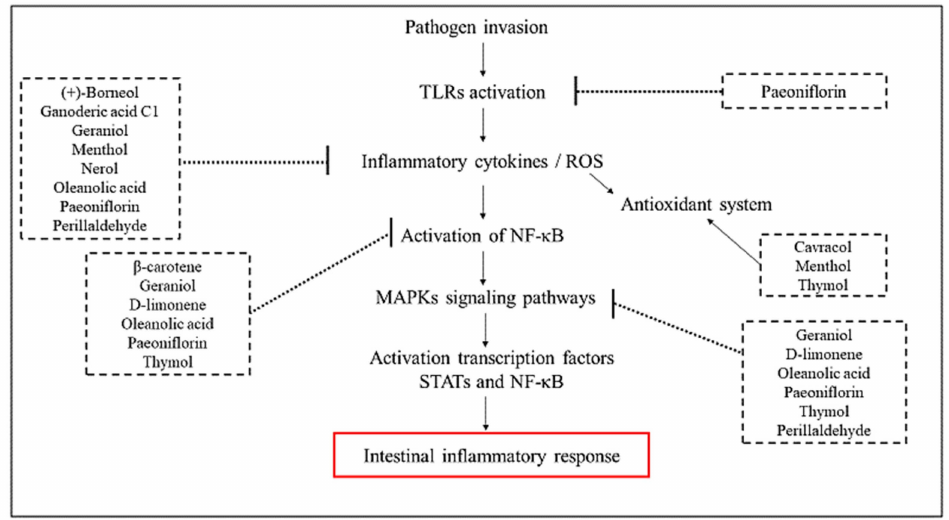
Figure 13. Diagram summarizing molecular mechanisms and pathways where terpenes act as anti-inflammatory